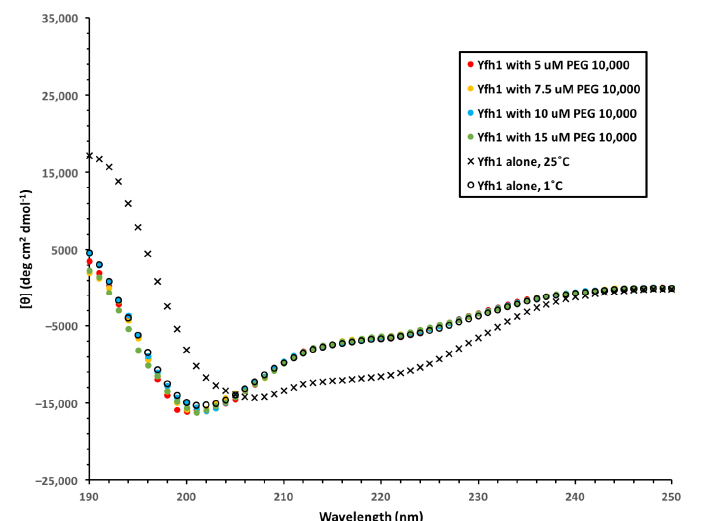
Figure 7. The effect of PEG 10,000 on Yfh1 Structure. CD spectra of 10 μM Yfh1 in the presence of various concentrations of PEG 10,000 at 1 °C in 10 mM Tris, pH 7.4.